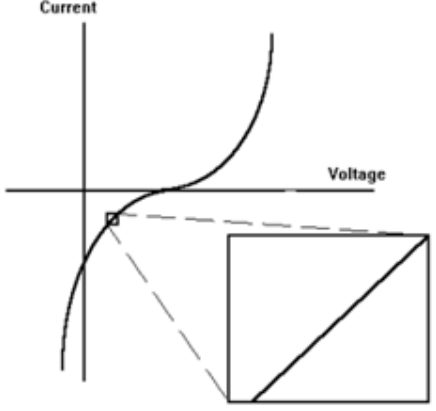
Figure 3. V vs. I Figure 3. V vs. I curve.